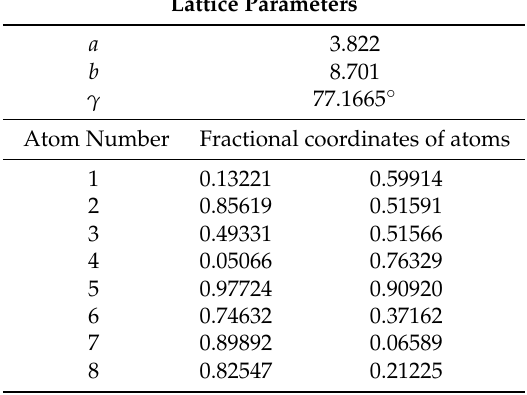
Table A2. Lattice parameters (Å) and fractional coordinates of atoms of Anisotropic-cyclicgraphene - oP8 - P1m1-primitive cell, Figure